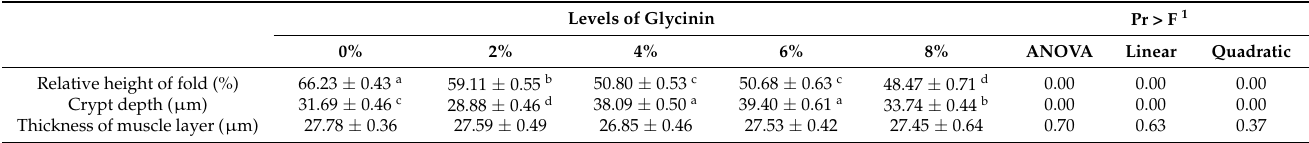
Table 3. Posterior intestinal morphology indexes of hybrid yellow catfish. Levels of Glycinin Pr > F 1 ANOVA Linear